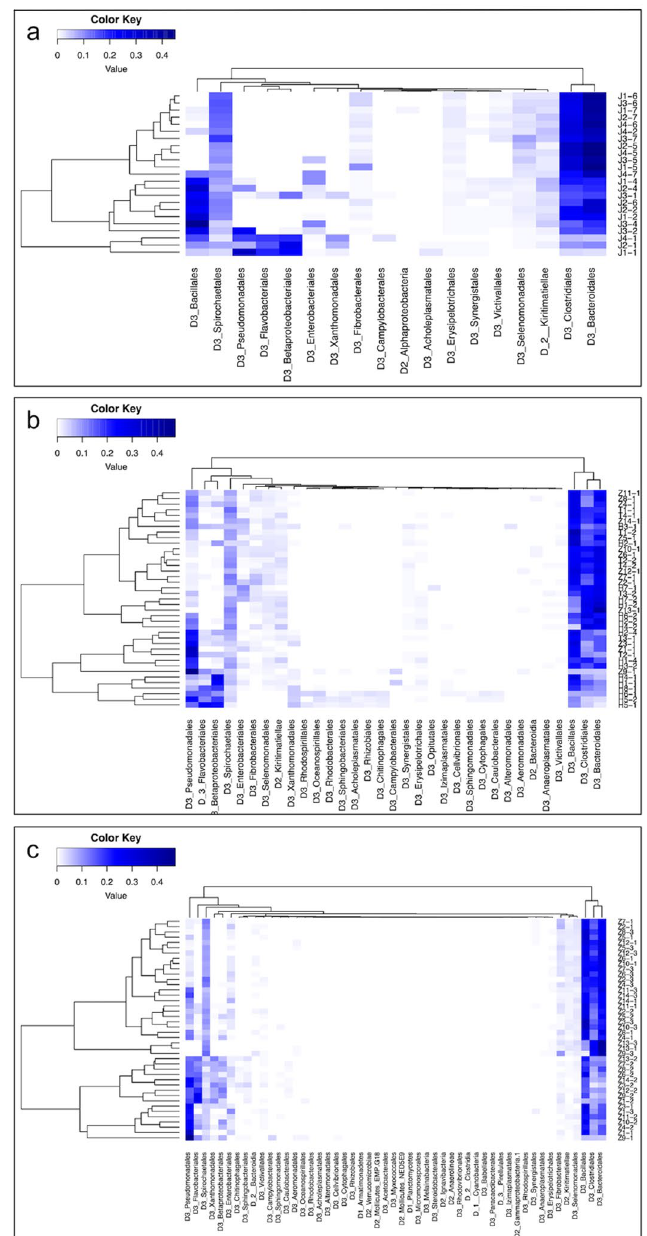
Figure 7. Maximum abundance heatmaps. Alterations in relative abundances of the annotated taxa orders in the gut microbiome of Asian elephants in relation to ( a) translocation, ( b) captivity and ( c) deworming. Elephant IDs and sample numbers are shown on the right side of the heatmaps. Sample IDs are identified by letters that describe the origin of each elephant where (J) represents TAA group from Hmaw Yaw Gyi camp, (H) represents DAA group from Hmaw Yaw Gyi camp, (T) represents DAA group from Taung Kya camp and (Z) represents elephants from Nay Pyi Taw Zoo in